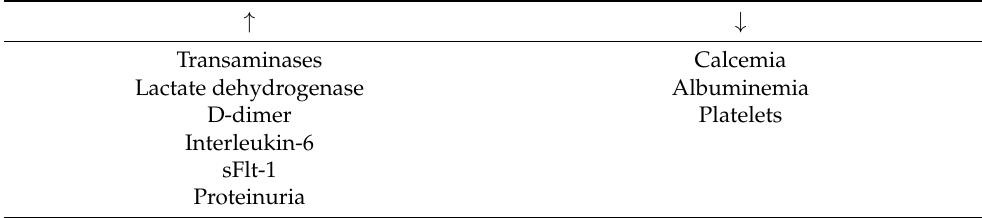
Table 2. Laboratory tests of preeclampsia and